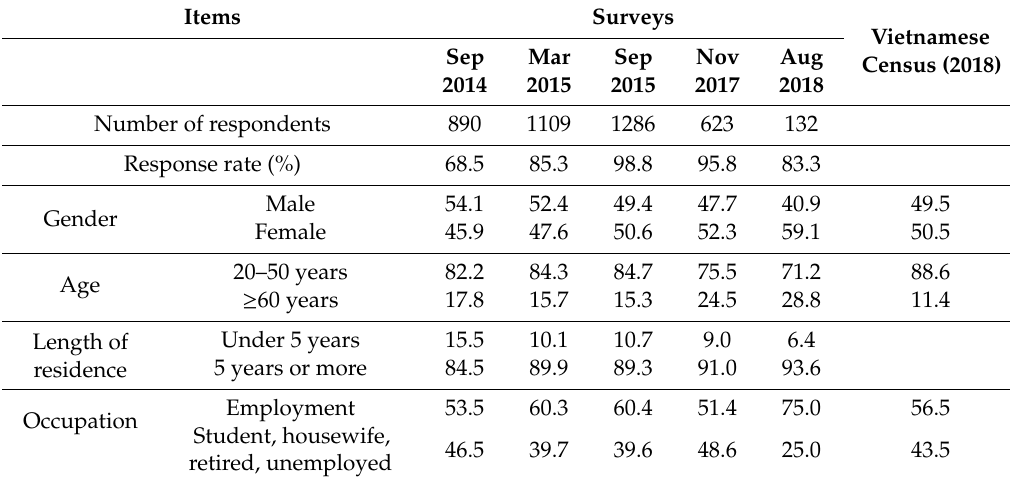
Table 2. Demographic data of the respondents in all the surveys.